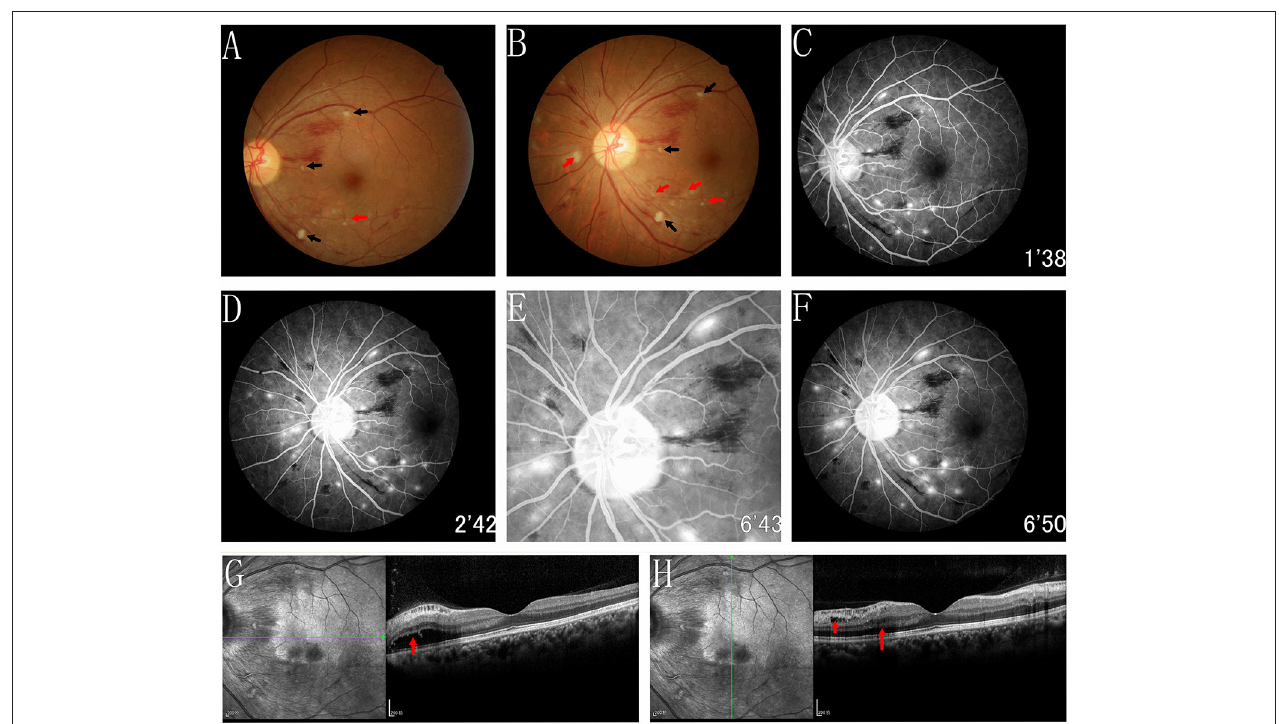
FIGURE 2 | Fundus photograph, FFA and SD-OCT of the left eye. (A,B) Funduscopic examination revealed retinal oedema, intraretinal haemorrhage, elschnig spots (red arrows), hard exudates and cotton-wool spots (black arrows) in left eye. (C–F) FFA showed multifocal sites of patchy hyperfluorescence in the early phase, with leakage during the entire imaging process describing elschnig spots, and blockage from the cotton wool spots. (G,H) SD-OCT showed the IRF (red arrows) with multilayered hyperreflective lesions, swelling of RNFL and relatively preservation of the EZ and RPE were observed.